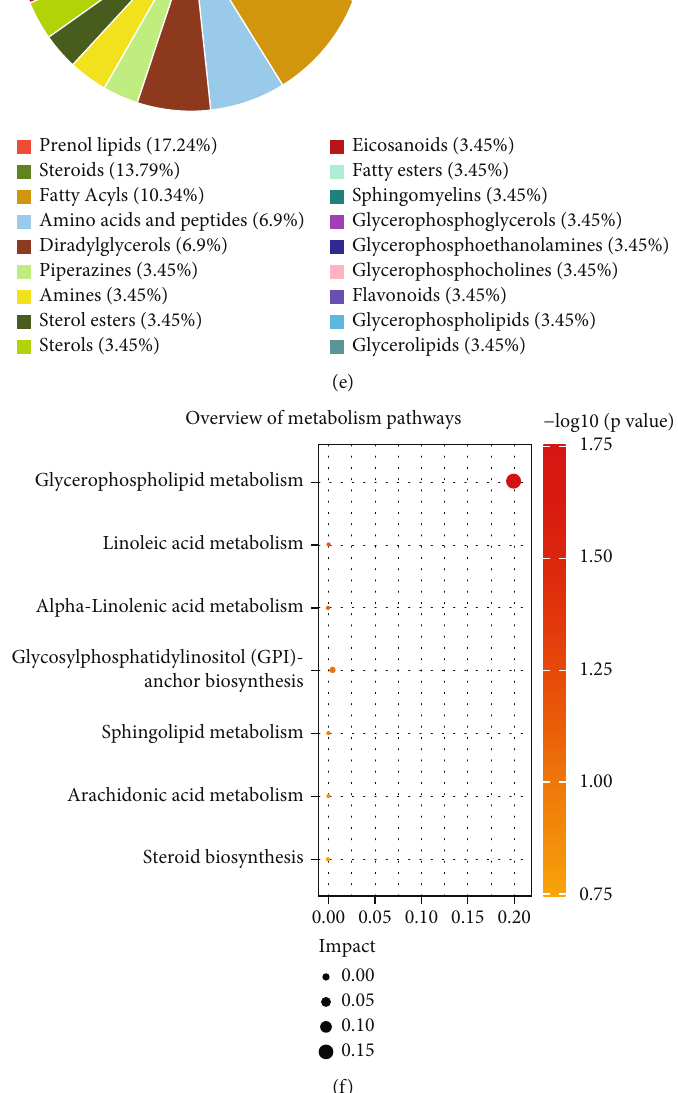
Figure 8: E ff ects of didymin on the metabolome in mice with ALI: (a) The total ion chromatogram (TIC) plot; (b) the orthogonal partial least-square discrimination analysis (OPLS-DA) plot; (c) the variable importance plot (VIP) diagram; (d) the metabolite volcano graphics; (e) the main enriched metabolite sets; (f) the enriched metabolic